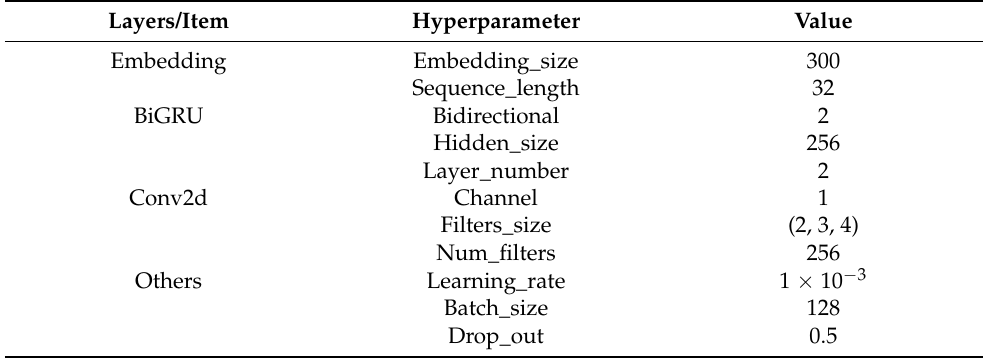
Table 2. Model hyperparameter